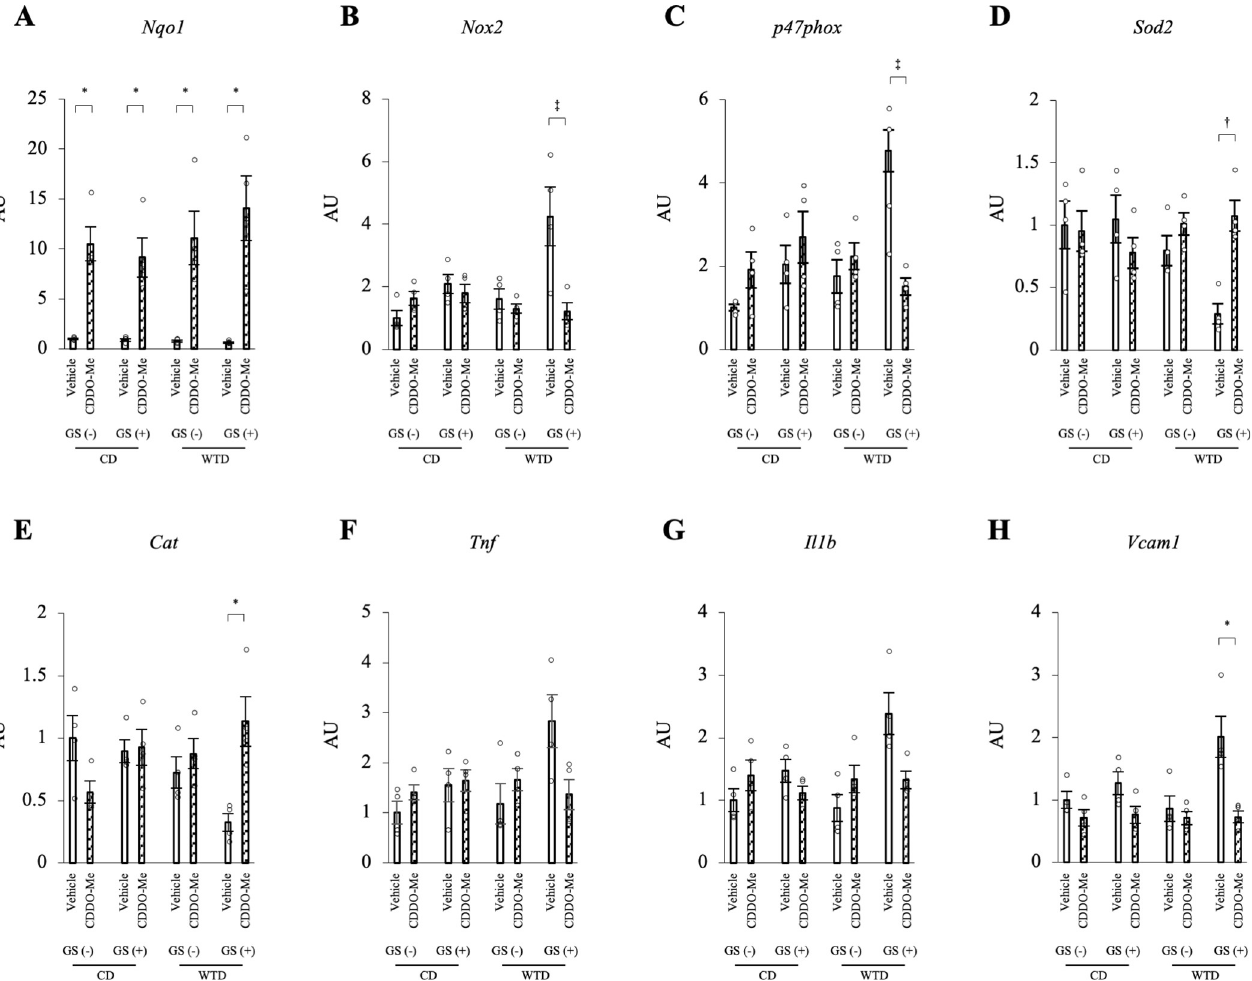
Fig 9. The effect of CDDO-Me (3 mg/kg) on gene expression. CDDO-Me suppresses the expression of the NOX2 mRNA and increases SOD2 and catalase mRNA expression in the thoracic aorta of the WTD-GS (+) group. A-H: Quantitative PCR analysis of the expression of NQO1 (A), NOX2 (B), p47phox (C), SOD2 (D), catalase (E), TNF α (F), IL1 β (G) and VCAM1 (H) mRNAs in the thoracic aorta. � P < 0.05, † P < 0.01, and ‡ P < 0.005, Bonferroni correction. The data are presented as the means ± SEM. N = 4 rats per group. CD, control diet; WTD, Western-type diet; GS, glucose spike.